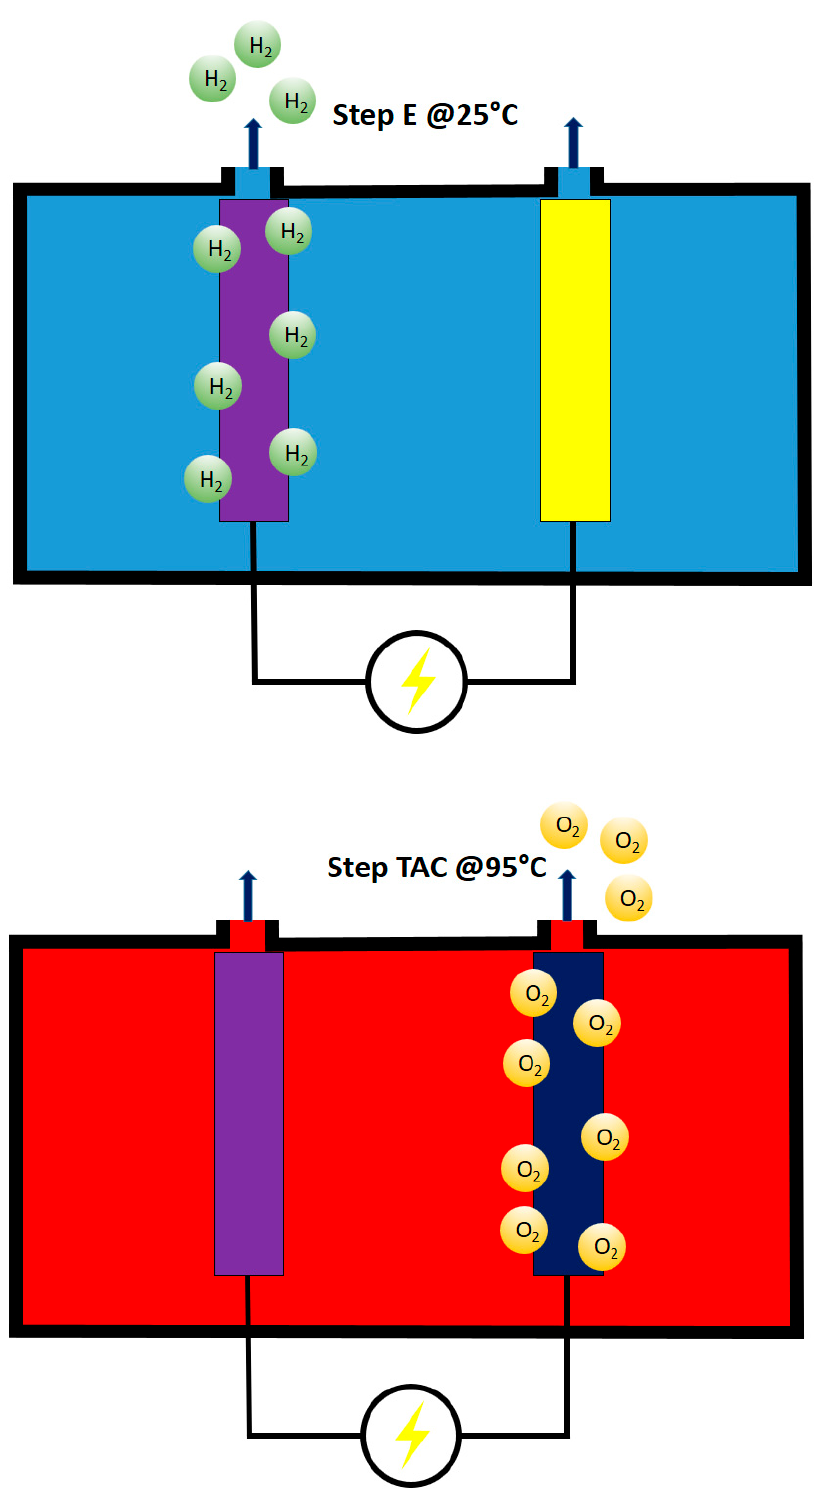
Figure 4. E-TAC hydrogen and oxygen production schematic. Alkaline electrolysis is based on the contemporary oxygen and hydrogen evolution reactions taking place at high temperatures. In this solution, the membrane does not allow the O 2 /H 2 crossover. In the case of E-TAC, the water-splitting process takes place in two